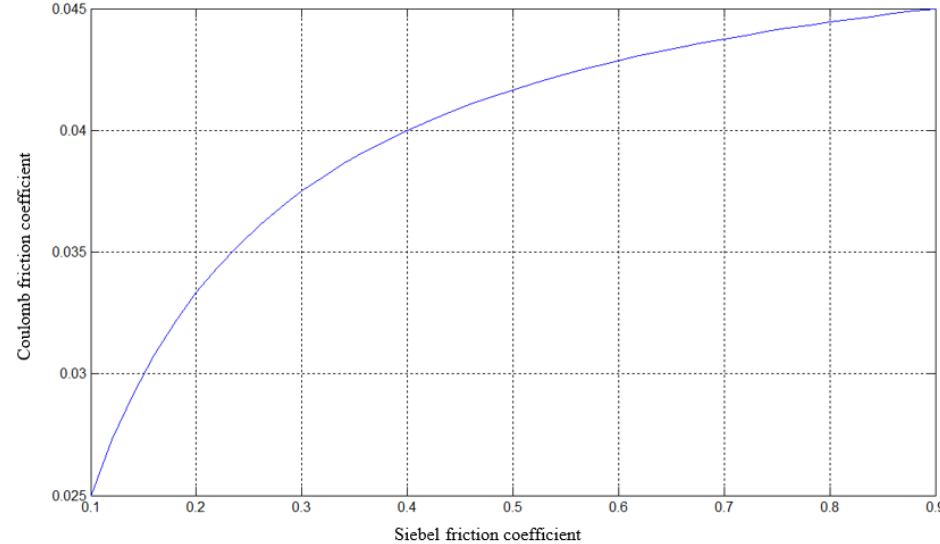
Figure 3. Coulomb friction coefficient vs. constant shear friction coefficient at λ l 1 = 10.